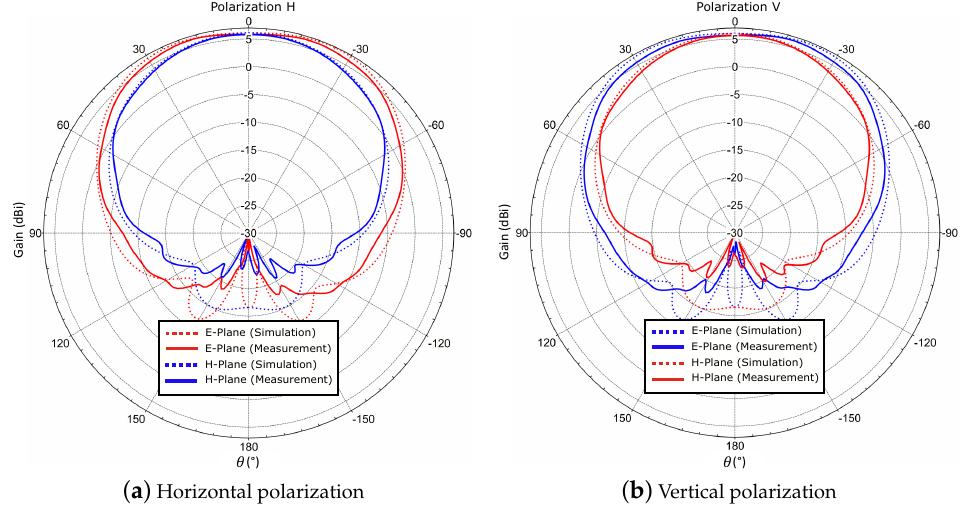
Figure 5. Simulated and measured radiation pattern of the single element @ f 0 = 1.325